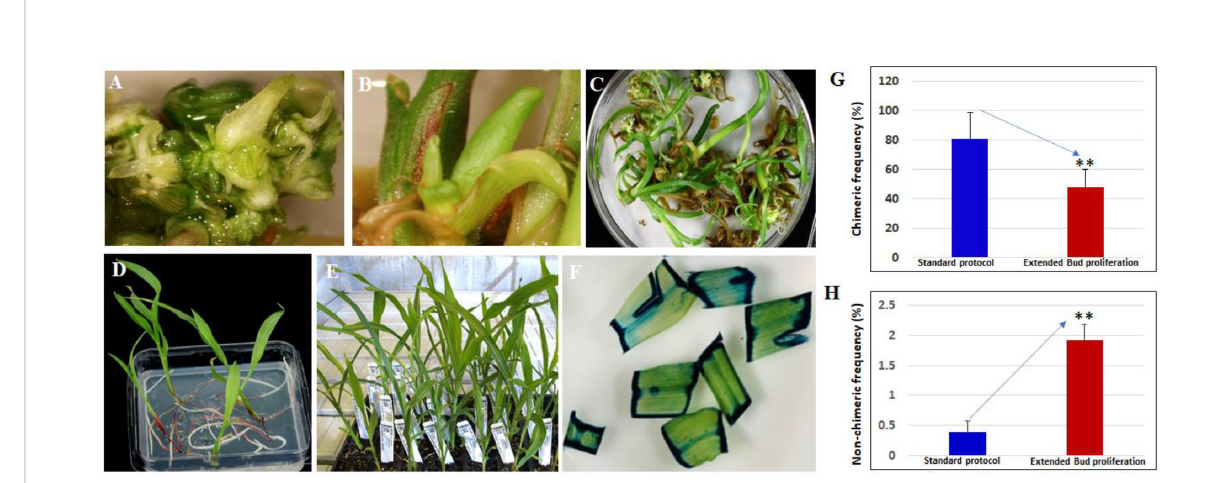
FIGURE 8 Reduction of chimeric event through the introduction of the extended bud proliferation step with selection and optimized hormone combination. (A , B) proliferation of glyphosate-resistant shoot buds on bud induction medium 4141 containing 3 mg/L thidiazuron, 2 mg/L picloram, and 30 mM glyphosate for two weeks; (C) Regeneration of glyphosate-resistant shoots on regeneration medium containing 20 mM glyphosate; (D) Glyphosate-resistant shoots developed a strong root system on rooting medium; (E) Transgenic plants with normal green leaf phenotype in plug; (F) gusA expression in non-chimeric glyphosate-resistant shoots; (G) Bud proliferation induction medium signi fi cantly (p<0.01) reduced the regeneration of chimeric shoots; (H) bud proliferation medium signi fi cantly (p<0.01) improved the overall production of non-chimeric events. ** indicates signi fi cance at <0.01 level.